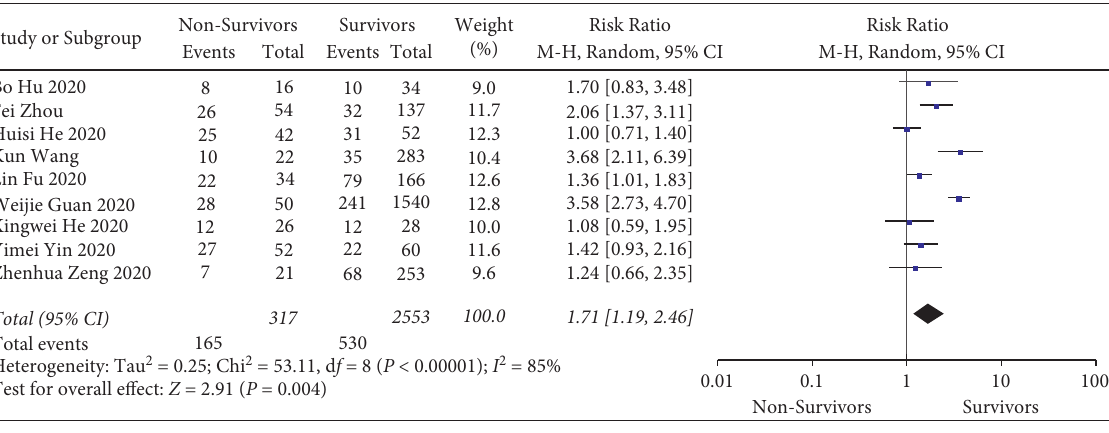
Figure 4: (a) Forest plots depict the comparison of the incidences of hypertension in severe/ICU and nonsevere/ICU patients. (b) Forest plots depict the comparison of the incidences of hypertension in nonsurvivors and survivors. Forest plots depict the comparison of the incidences of cardiac injury in ICU/severe and non-ICU/severe patients.